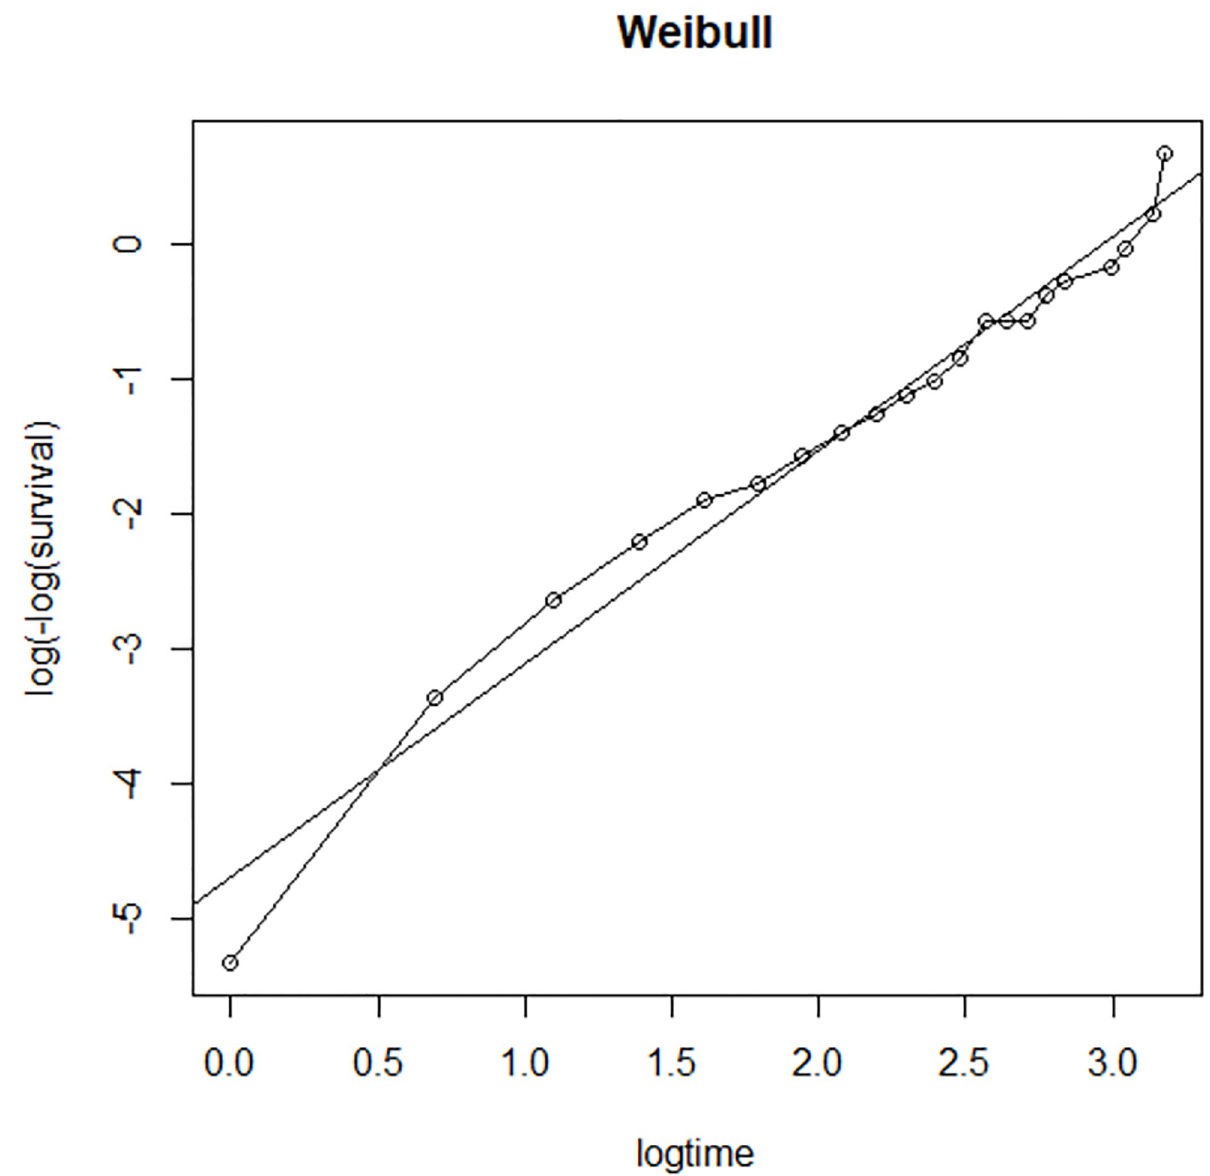
Fig 9. Adequacy checking for the parametric Weibull baseline distribution, LPAC, 2015–2019.